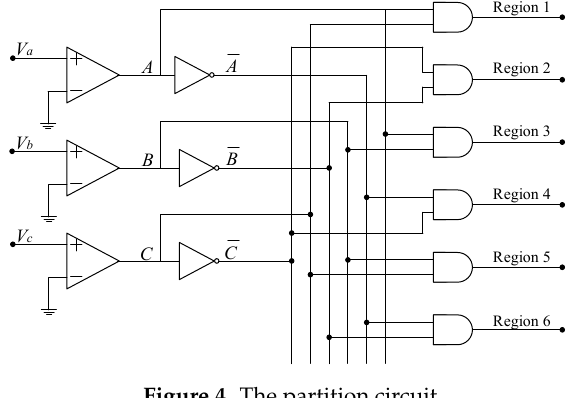
Figure 4. The partition circuit.